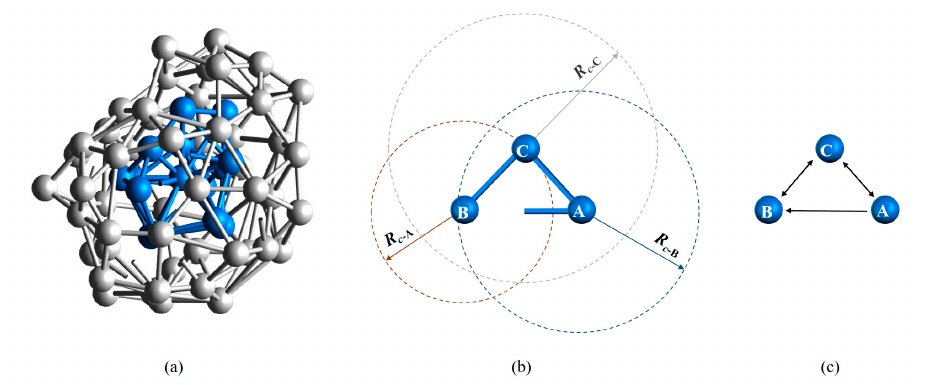
Figure 2. Directed graph representation of interatomic connections. ( a ) Bonding relationship within a BCC LaSC and that between the neighbor atoms of the BCC LaSC; here, the layer-to-layer bonds are not shown. ( b ) Bi-directional and one-way edges between atoms. ( c ) The graphic interpretation of the bonding relationship in ( b ).